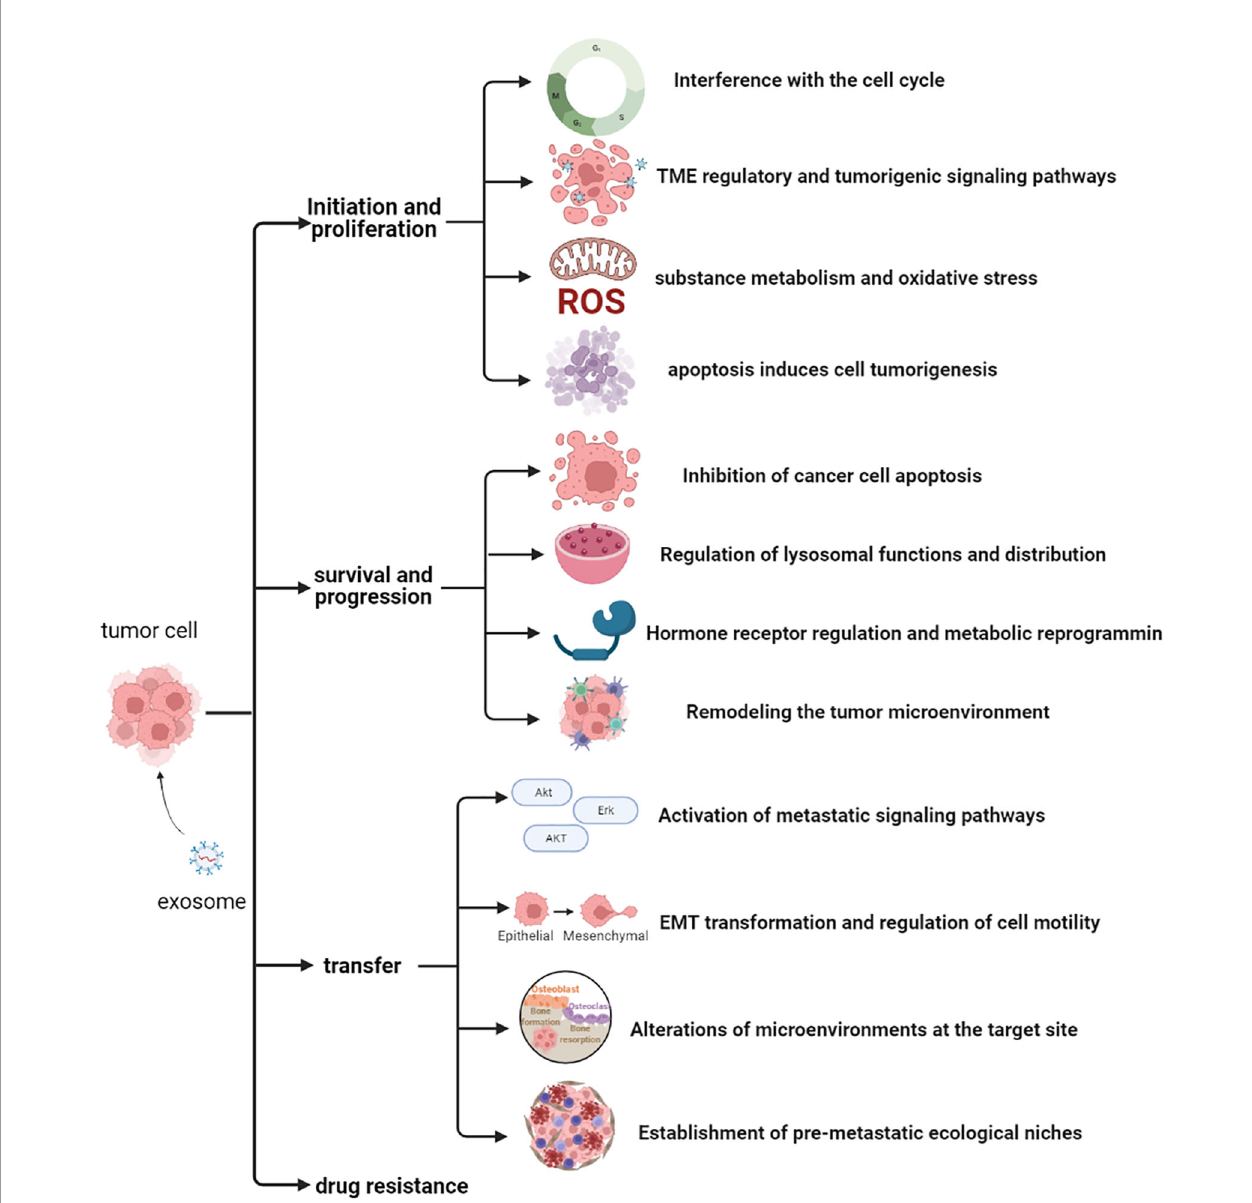
FIGURE 2 | Potential mechanisms of action of exosomal proteins in prostate